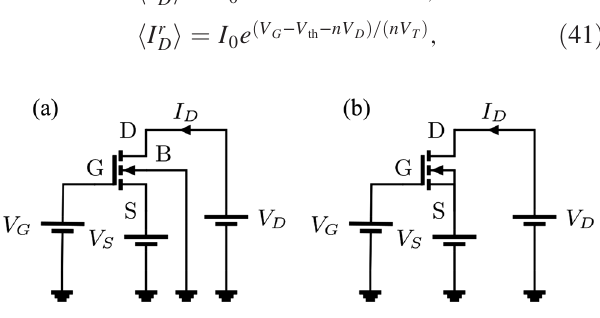
FIG. 3. An nMOS transistor. In (a), the bulk ( B ) terminal is grounded, and all other voltages are measured with respect to it. This process allows one to preserve the symmetry between the source ( S ) and drain ( D ) terminals that is broken by connecting S and B together to obtain a three-terminal device like in (b).